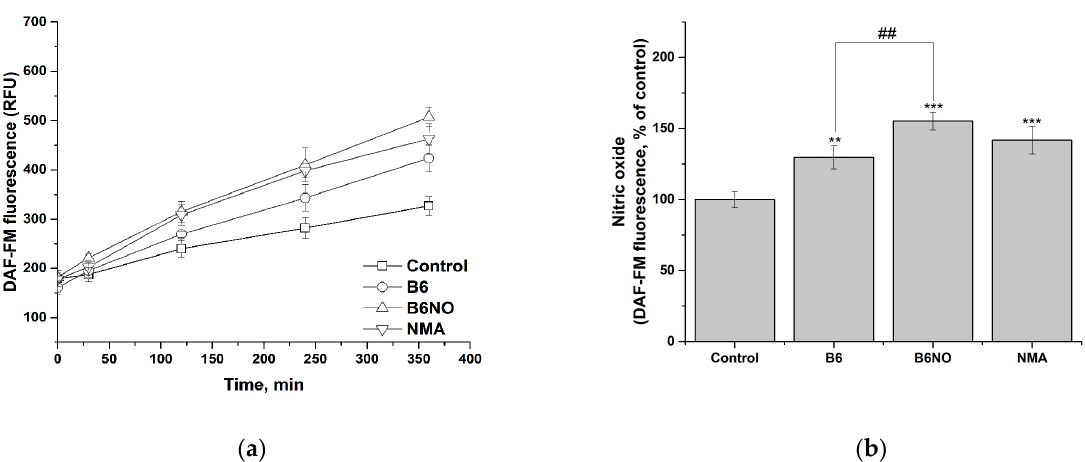
Figure 8. Influence of B6NO, vitamin B6 and NMA on the intracellular NO formation in HepG2 cells and measured using the DAF-FM assay. Time dependence of intracellular nitrogen monoxide concentration ( a ) and relative concentration of intracellular nitrogen monoxide after 6 h of exposure to compounds ( b ). Significant differences are shown as ** p < 0.01; *** p < 0.001 vs. control; as ## p < 0.01 B6NO vs. vitamin B6.